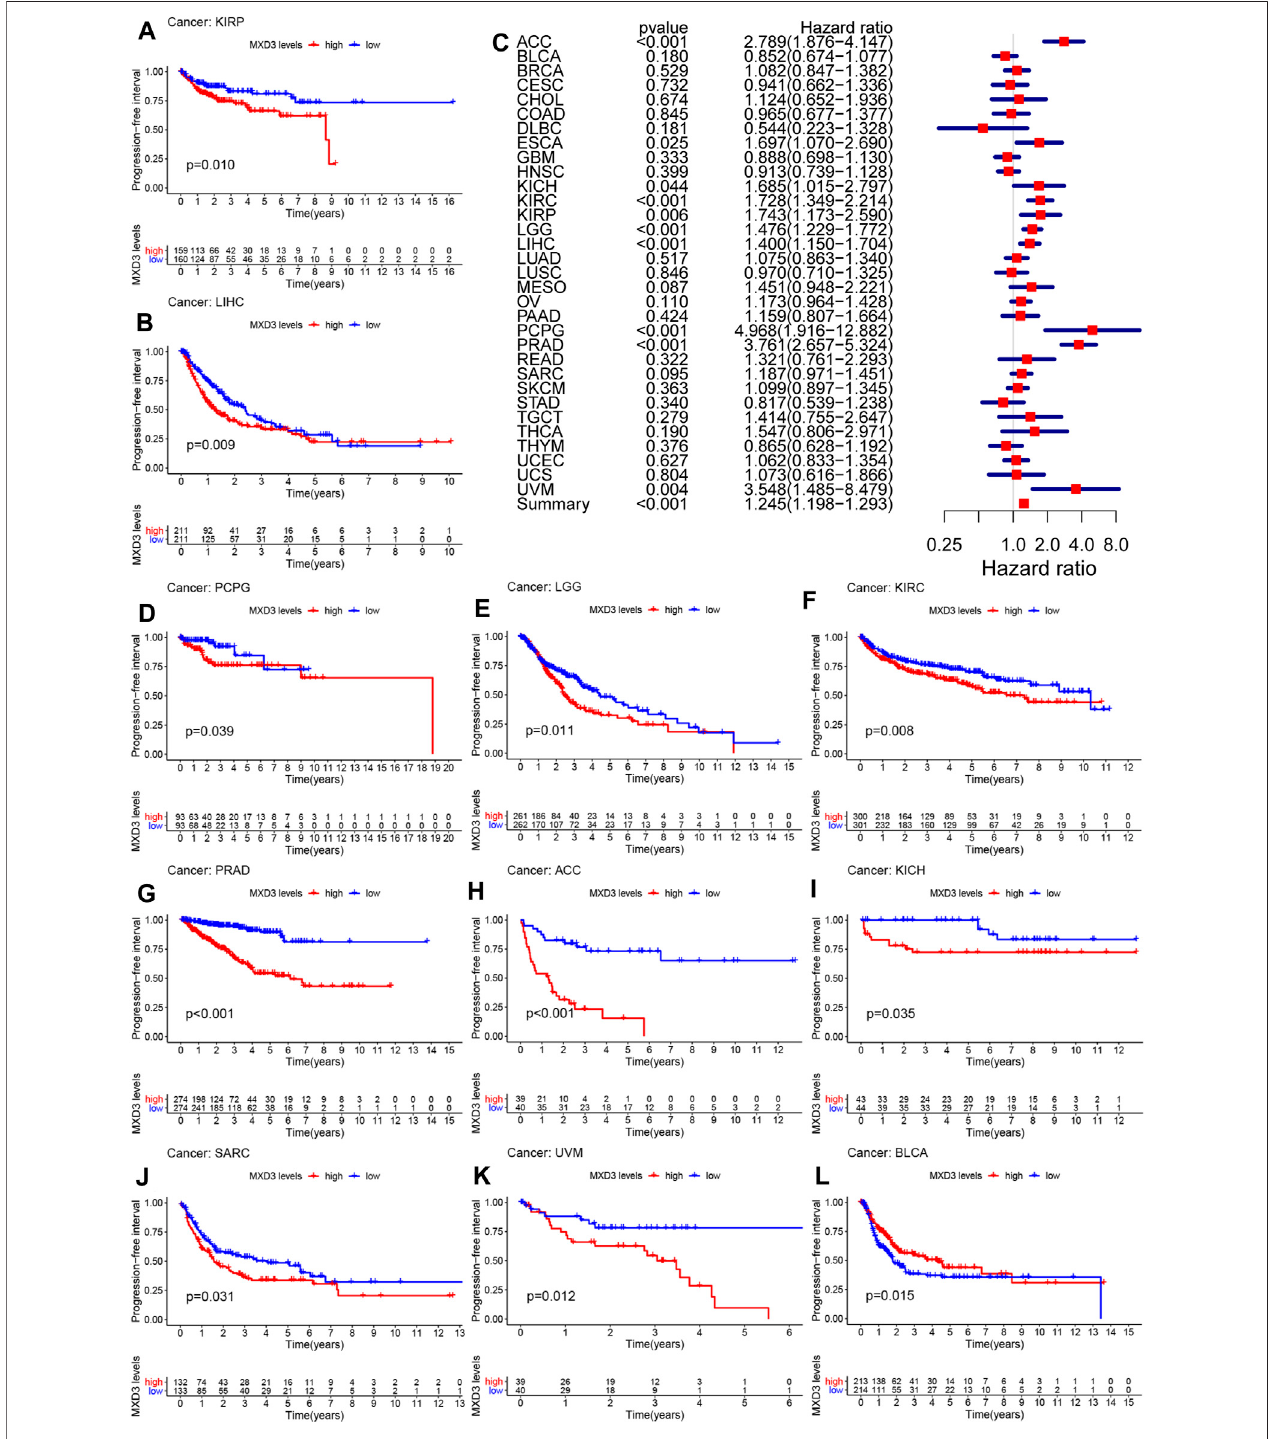
FIGURE 5 | PFI with different MXD3 expression in KIRP (A) , LIHC (B) , PCPG (D) , LGG (E) , KIRC (F) , PRAD (G) , ACC (H) , KICH (I) , SARC (J) , UVM (K) , and BLCA (L) . Cox regression of MXD3 and PFI (C) in cancer types.